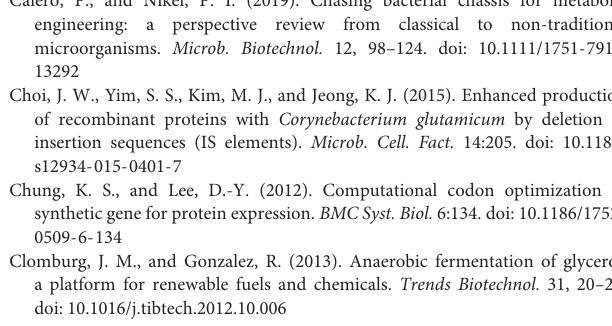
Supplementary Figure 2 | Comparison the soluble expression of 196 GOI in our library according to SDS-PAGE. (A–T) 0.15 OD (10-well gel) or 0.075 OD (15-well gel) prepared crude protein samples were loaded to the corresponding protein gel wells. V, V. natriegens VnDX; E, E. coli BL21(DE3); Ctrl, Glucose dehydrogenase from Bacillus subtillis contained in each batch of fermentation as a positive control; Blue box, GOI possessing higher expression in VnDX than BL21(DE3); Orange box, GOI possessing the same expression in VnDX and BL21(DE3); Gray box, GOI possessing higher expression in BL21(DE3) than VnDX. Numbers above the lanes represent V. natriegens or E. coli strains and the detailed information of these strains were shown in Supplementary Table 3 . Supplementary Figure 3 | Classifications of the evaluation results of these 196 GOI in VnDX and BL21(DE3) according to enzyme families, sources and lengths of amino acids. (A) Classification according to enzyme family. (B) Classification according to enzyme sources. (C) Classification according to the length of enzymes. VnDX>BL21(DE3): GOI possessing higher expression in VnDX than BL21(DE3); VnDX=BL21(DE3): GOI possessing the same expression in VnDX and BL21(DE3); VnDX<BL21(DE3): GOI possessing higher expression in BL21(DE3) than VnDX. Supplementary Figure 4 | Growth curve and protein expressions of four GOI in BHIv2, TBv2, and LBv2 culture medium. (A) Simvast acyltransferase from Aspergillus terreus . (B) D-amino acid transaminase from Silicibacter promeroyi DSS-3. (C) Haine racemase from Agrobacterium tumefaciens str. C58. (D) Maltooligosaccharide trehalose hydrolase from Arthrobacterium S 34. 0.15 OD 600 (10-well gel) prepared crude protein samples were loaded to the corresponding protein gel wells. Error bars represent the SD of n = 3 technical replicates. Supplementary Figure 5 | The growth and GDH catalytic efficiency curve of VnDX/pGDH at 30 or 28 ◦ C. (A) the growth curve of VnDX/pGDH at 30 or 28 ◦ C. (B) the GDH catalytic efficiency (U/ml) curve of VnDX/pGDH at 30 or 28 ◦ C. Error bars represent the SD of n = 3 technical replicates. Supplementary Figure 6 | The GDH catalytic efficiency per OD 600 (U · ml − 1 · OD − 1 ) in BL21(DE3)/pGDH and VnDX/pGDH at the end of fermentation (24 h). Error bars represent the SD of n = 3 technical replicates. Supplementary Figure 7 | The growth curve of V. natriegens at 37 or 30 ◦ C. Error bars represent the SD of n = 3 technical replicates. Supplementary Figure 8 | The SDS-PAGE of soluble and insoluble expression of 3 GOI. 0.15 OD 600 prepared crude protein samples were loaded to the corresponding protein gel wells. V, V. natriegens VnDX; E, E. coli BL21(DE3); Sol, soluble expression proteins; Insol, insoluble expression proteins. The GOI band is marked with red arrows. The detailed information of these GOI were shown in Supplementary Table 3 . Supplementary Table 1 | Enzyme classification of 196 GOI in our library. Supplementary Table 2 | Strains and plasmids used in this work. Supplementary Table 3 | Detailed information of 196 GOI in E. coli and V. natriegens . Supplementary Table 4 | Primers used in this